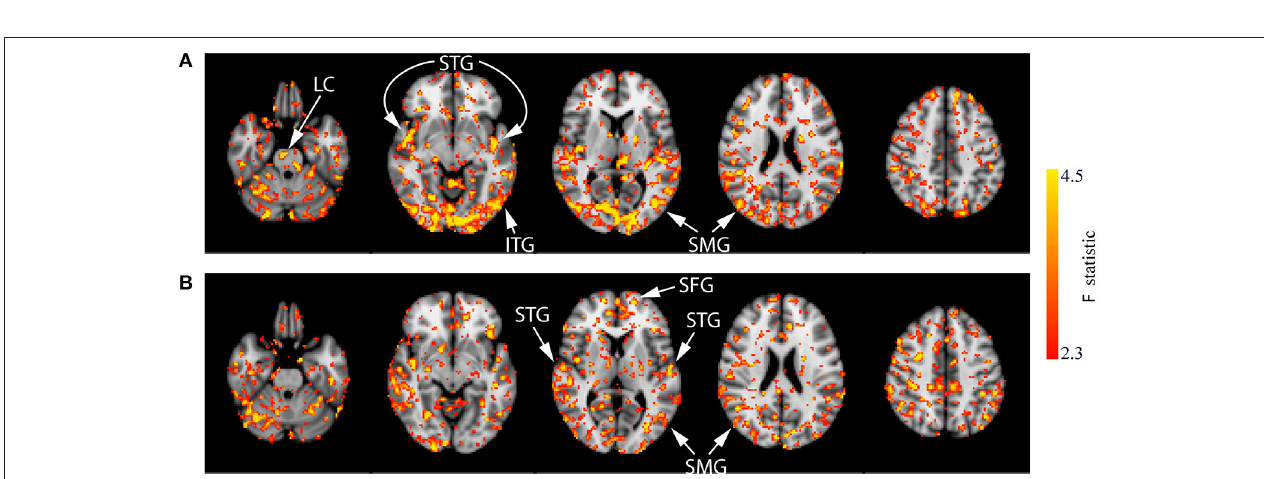
FIGURE 5 | Results of the unpaired t- tests between CON and ACT 2mA for the change between session 1 pre-stimulation and session 1 post-stimulation (top row), session 2 post-stimulation (middle row), and session 3 post-stimulation (bottom row). Axial slices are taken from MNI coordinates z = − 26, − 8, 6, 22, and 44mm (left to right).